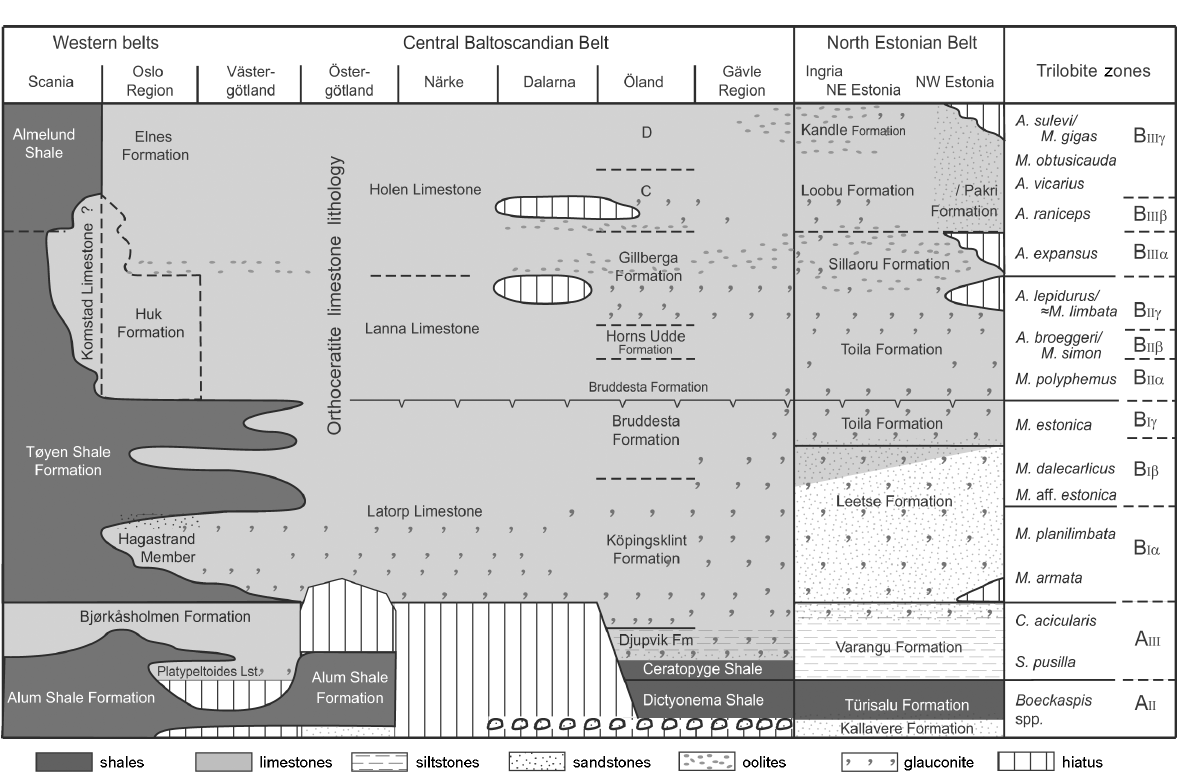
Fig. 4. Distribution of main lithologies in Baltoscandia, with generally deeper facies to the left, shallower to the